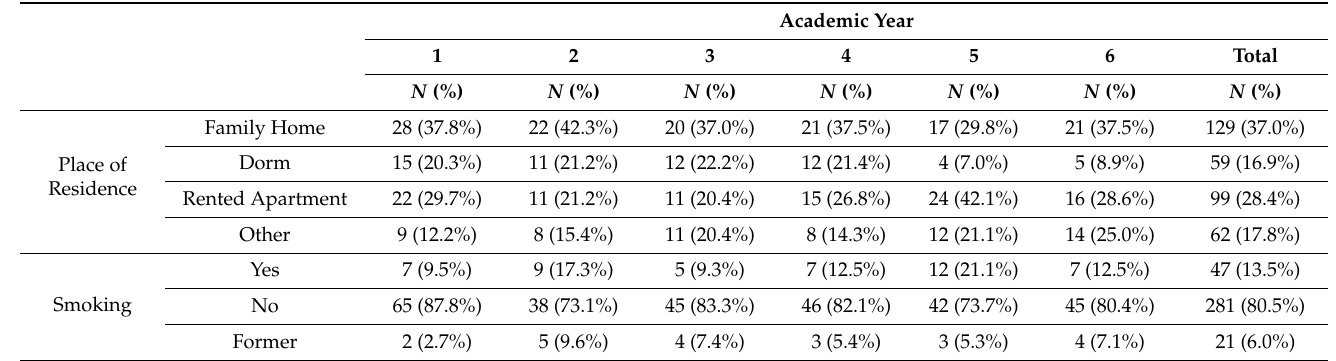
Table 2. Place of residence and smoking status by academic year.